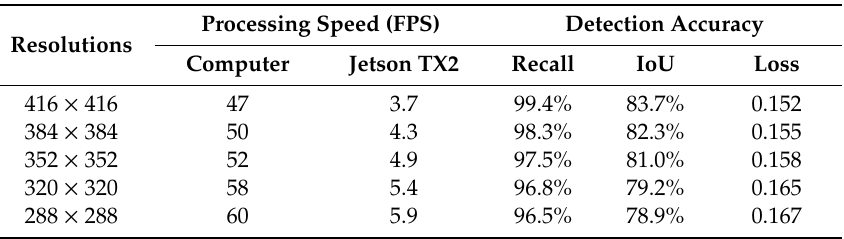
Table 4. The processing speed and detection accuracy of images with di ff erent resolutions on the computer and the Jetson TX2 embedded